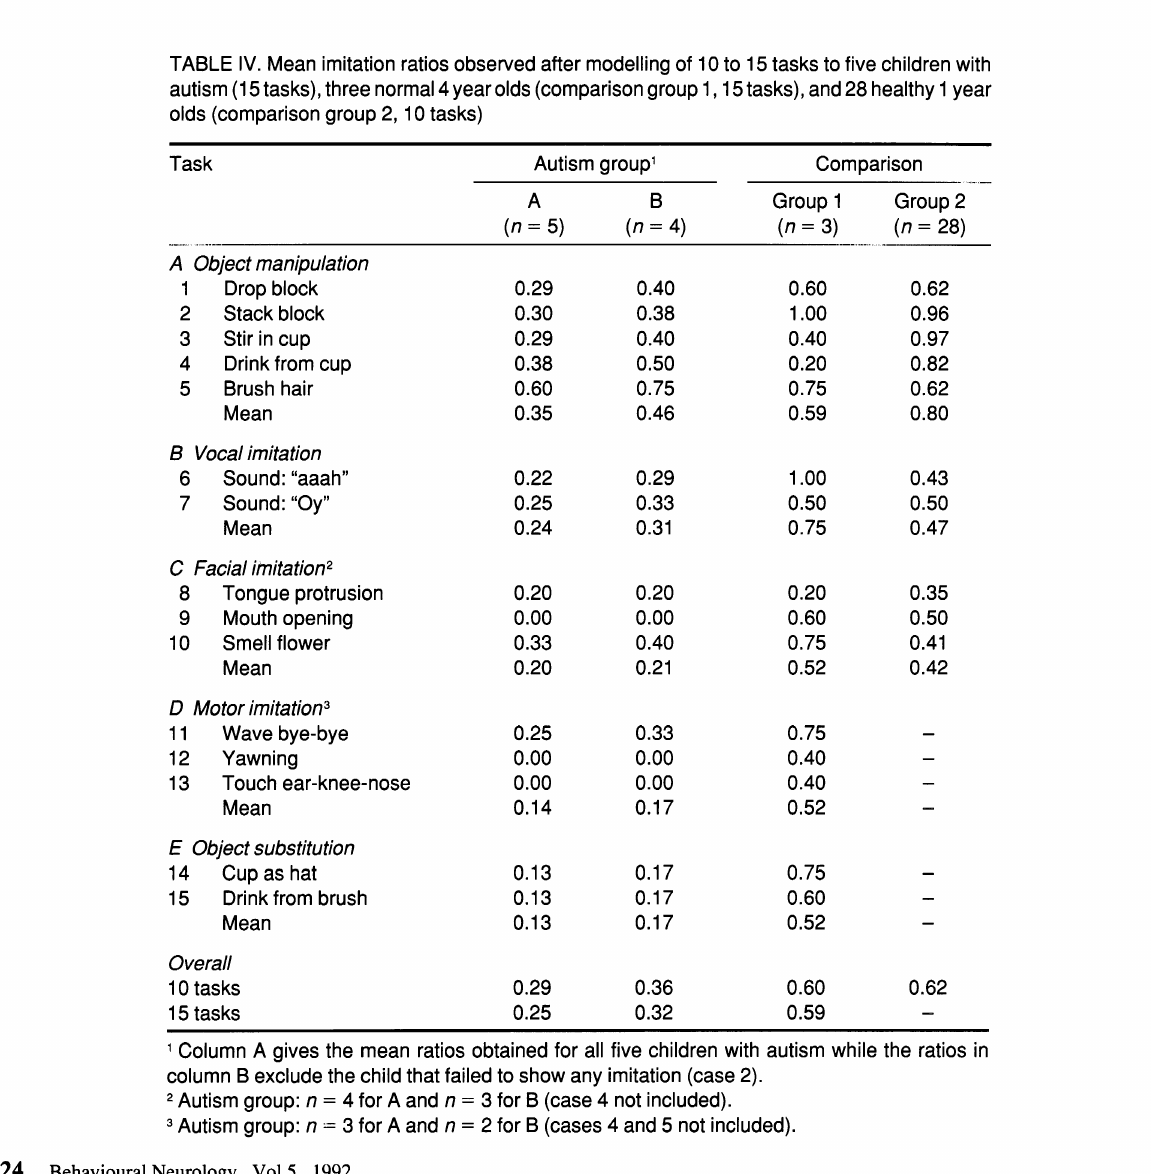
TABLE IV. Mean imitation ratios observed after modelling of 10 to 15 tasks to five children with autism (15tasks), three normal4yearolds (comparison group 1, 15tasks), and 28 healthy 1 year olds (comparison group 2, 10 tasks) Task Autism